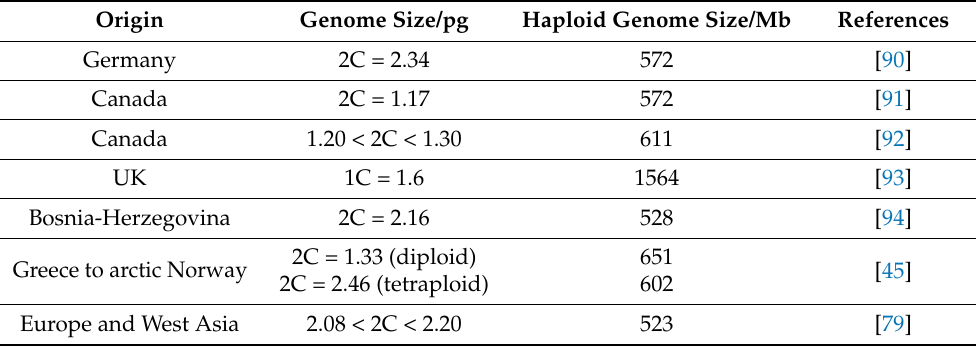
Table 1. Estimation of Urtica dioica genome sizes reported in the literature. The C value expressed in picogram is the mass of the haploid content of a cell. For diploid organisms, each chromosome is present in two copies. To eliminate the redundancy, the final mass is halved or announced as 2C [88]. Genome size (bp) = (0.978 × 10 9 ) × amount of DNA (pg) [87]; or 1 pg = 978 Mb